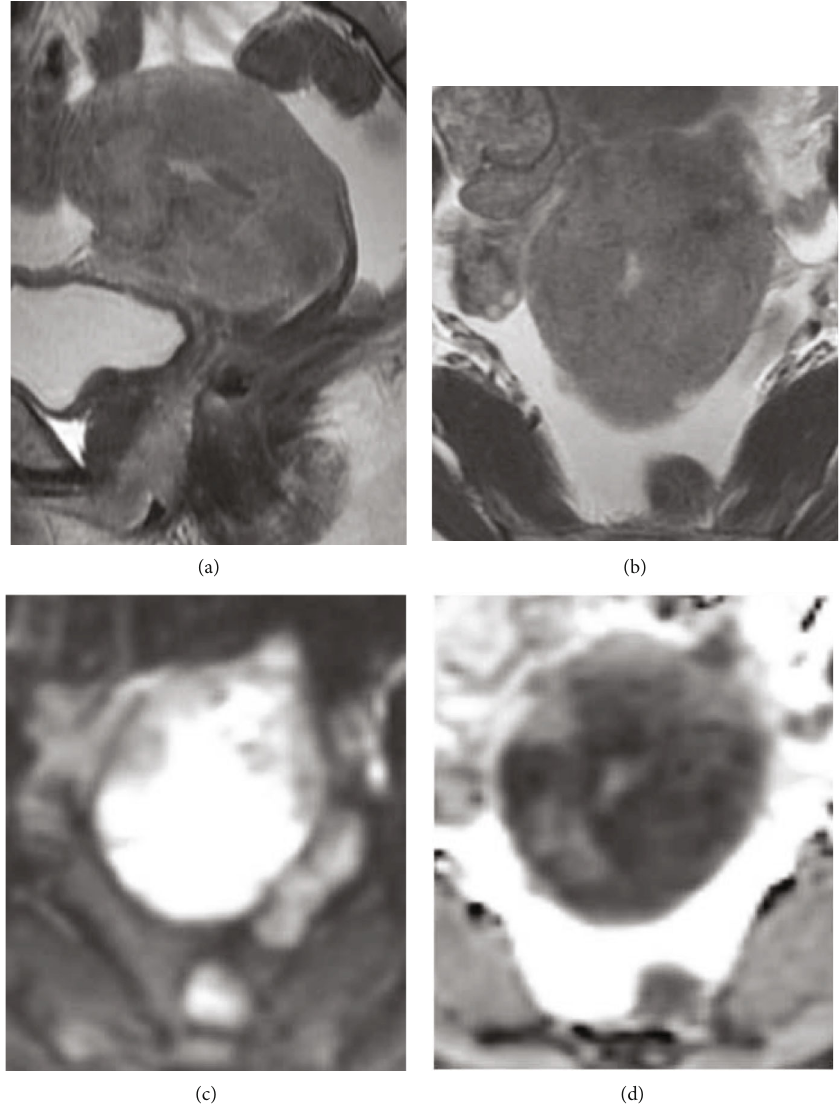
Figure 3: (a) Sagittal T2-weighted MRI image of the uterus and the vagina: the myometrium signal intensity was higher than that of the intestinal stroma. Similar intensity was observed in the lower vagina, the vulva, and a nodule on Douglas ’ pouch. (b) Axial T2-weighted MRI image of the uterus and the pelvis. The signal intensity of the myometrium was higher than that of the coccygeus muscle. (c) Axial di ff usion-weighed image of the uterine body. The entire myometrium showed high intensity. (d) Apparent di ff usion coe ffi cient (ADC) map. The mean ADC value of the whole uterus was 0 : 950 × 10 − 3 mm 2 /s with 0 : 720 × 10 − 3 mm 2 /s of it being covered by the darkest